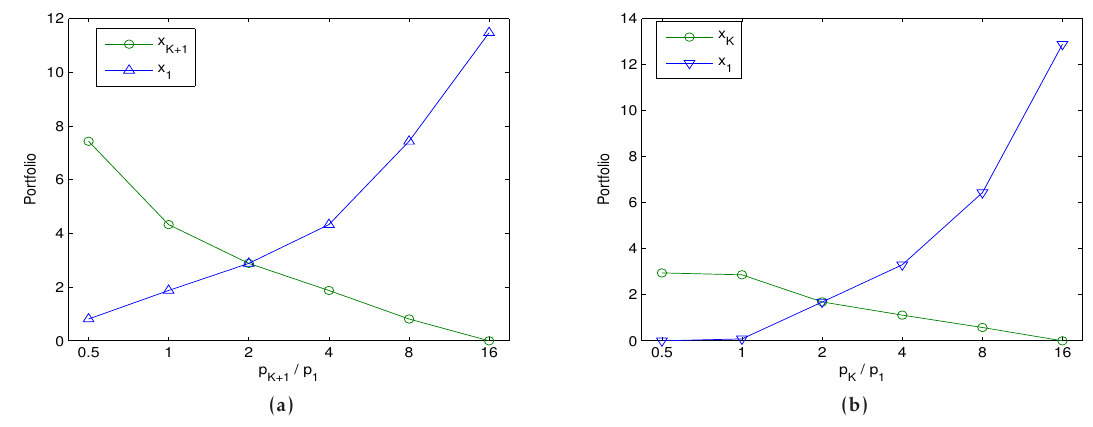
Figure 10. Optimal portfolio composition when the ratio of the unit price of the K -region secondary contract to that of the single-region secondary contract is increased; (a) Scenario A (b) Scenario B.